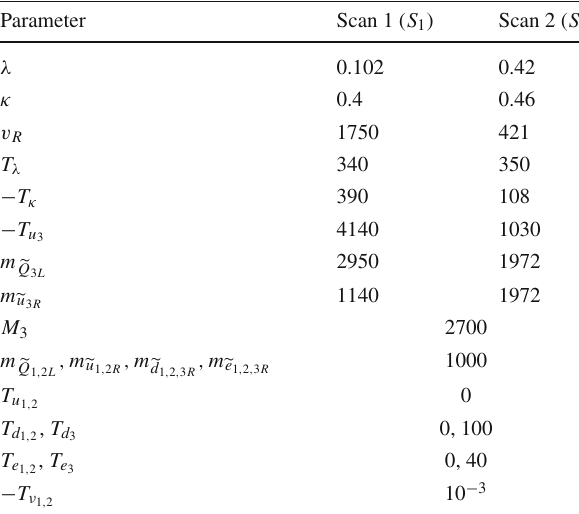
Table 3 Low-energy values of the input parameters that are fixed in the two scans. The VEV v R and the soft trilinear parameters, soft gluino masses and soft scalar masses are given in